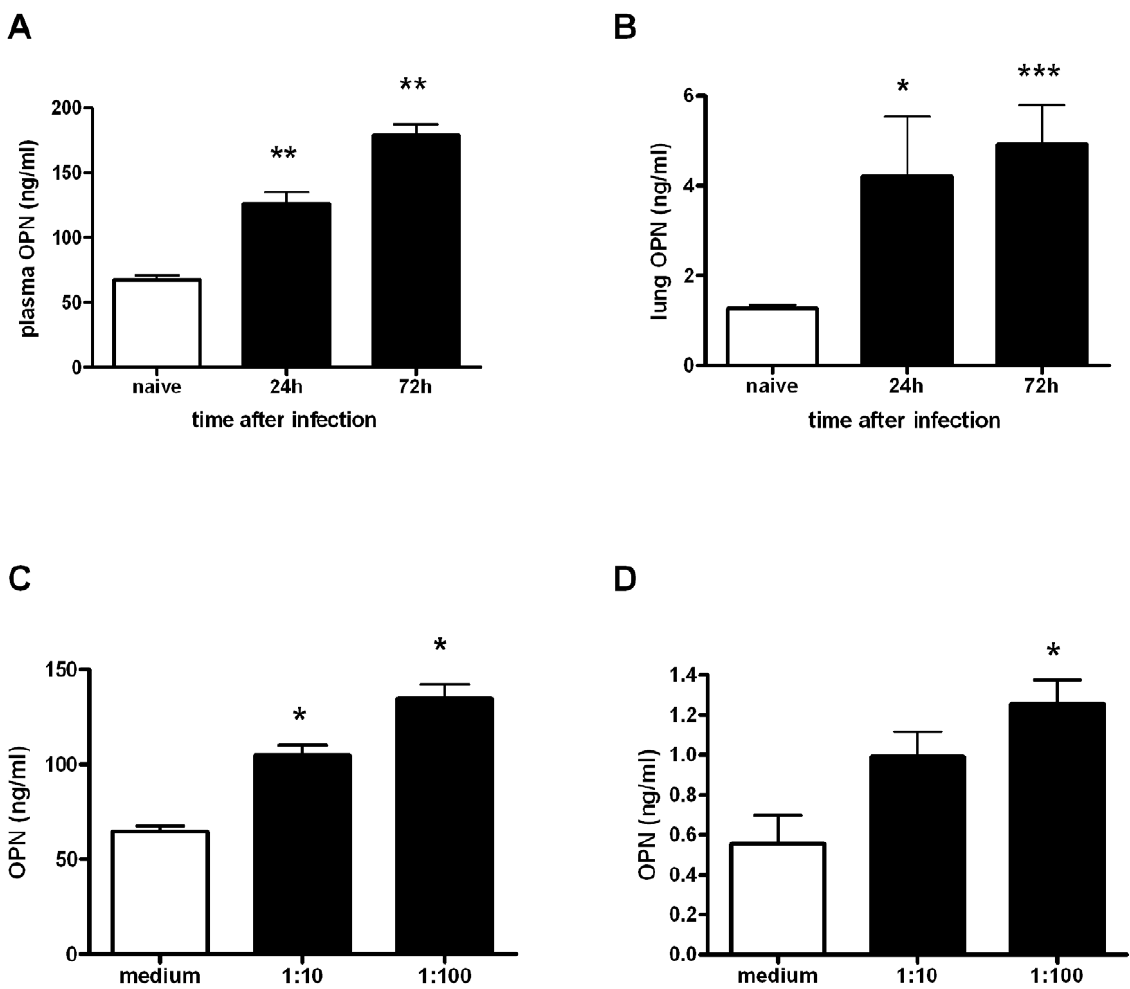
Figure 2. Experimental murine melioidosis results in elevated OPN concentrations in plasma and lungs. OPN concentrations in (A) plasma and (B) lung before, 24 and 72 h after intranasal infection with 10 3 CFU of B. pseudomallei . Data are expressed as means 6 SEM; n=8 mice/ group, * P , 0.05, ** P , 0.01 and *** P , 0.001 as compared to t=0. OPN concentrations in culture supernatants after incubation of (C) MH-S and (D) MLE-15 cells with medium or heat-killed B. pseudomallei (MOI 1:10 and 1:100) for 4 h. Data are expressed as means 6 SEM; n=4/group, * P , 0.05 as compared to medium stimulation.